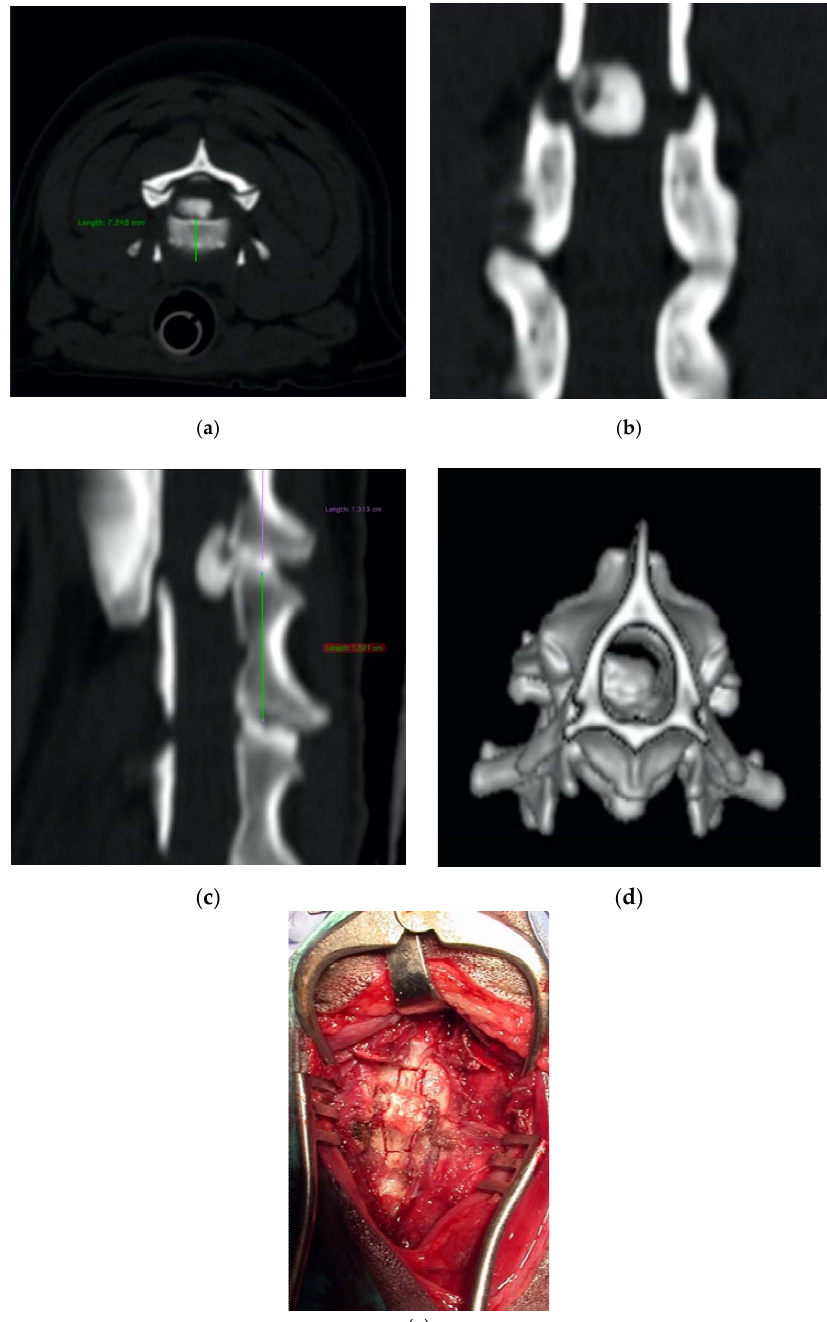
Figure 7. Axial ( a ), coronal ( b ), sagittal ( c ), and 3D ( d ) cervical CT scan showing a C2-C3 disk extrusion in a seven-year-old dachshund su ff ering from a progressive tetraplegia. Ventral slot decompression was obtained by means of long angled large saw tip (OT7, Osteotomy Tips Kit, Mectron Medical Technology, Genoa, Italy) ( e